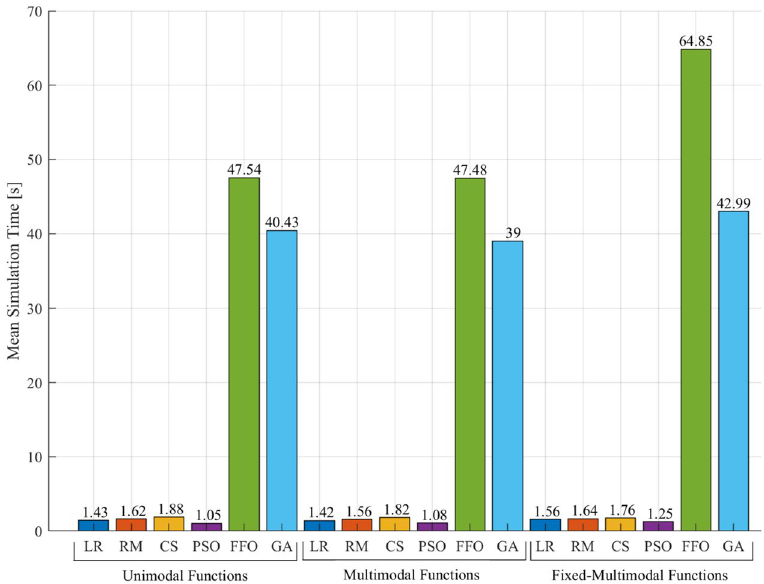
Figure 9. Average simulation time.